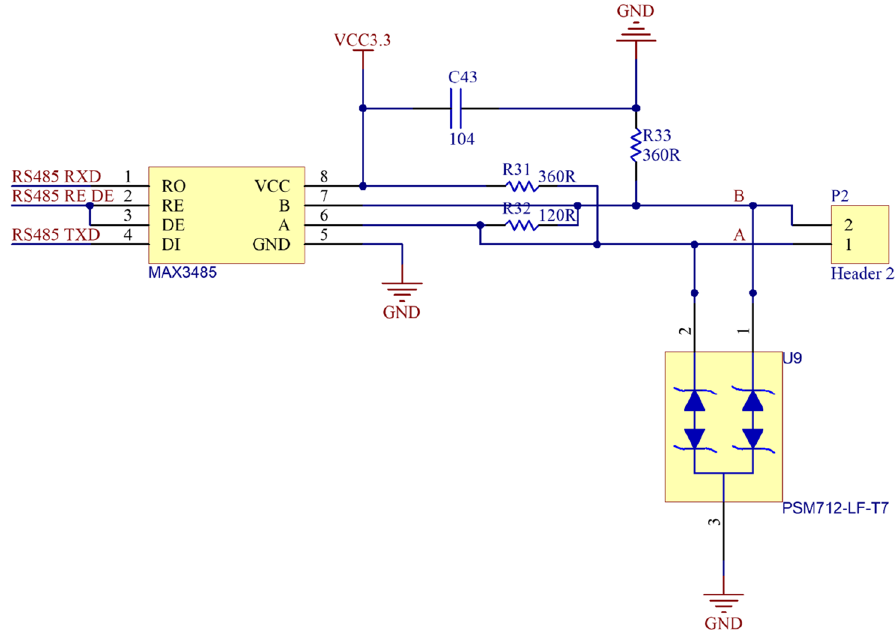
Fig. 4 RS485 module circuit